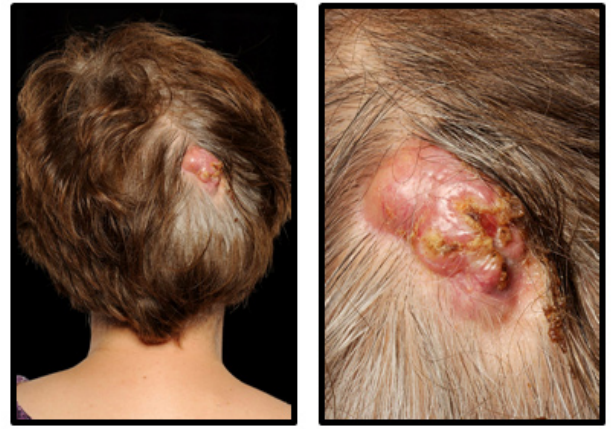
Figure 1. Clinical examined identified a 3 x 4 cm raised, indurated lesion with crusting, superficial ulceration and a serosanguinous discharge.